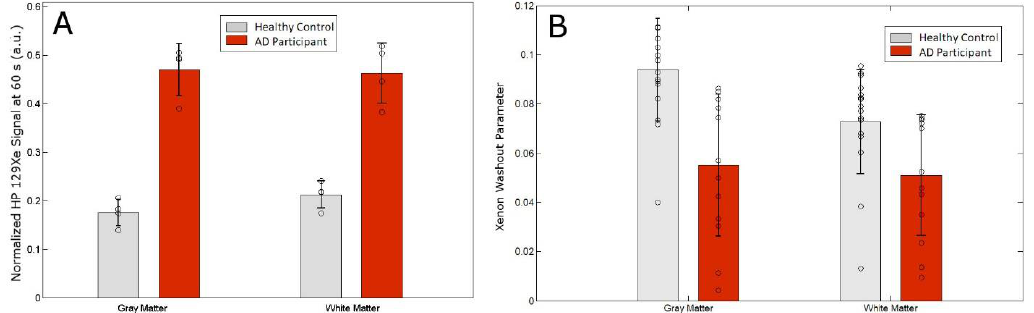
Figure 3. ( A ) Normalized 129 Xe retention at 60 s after the breath-hold for Xe-WM and Xe-GM. ( B ) Xenon washout parameter for gray matter and white matter.